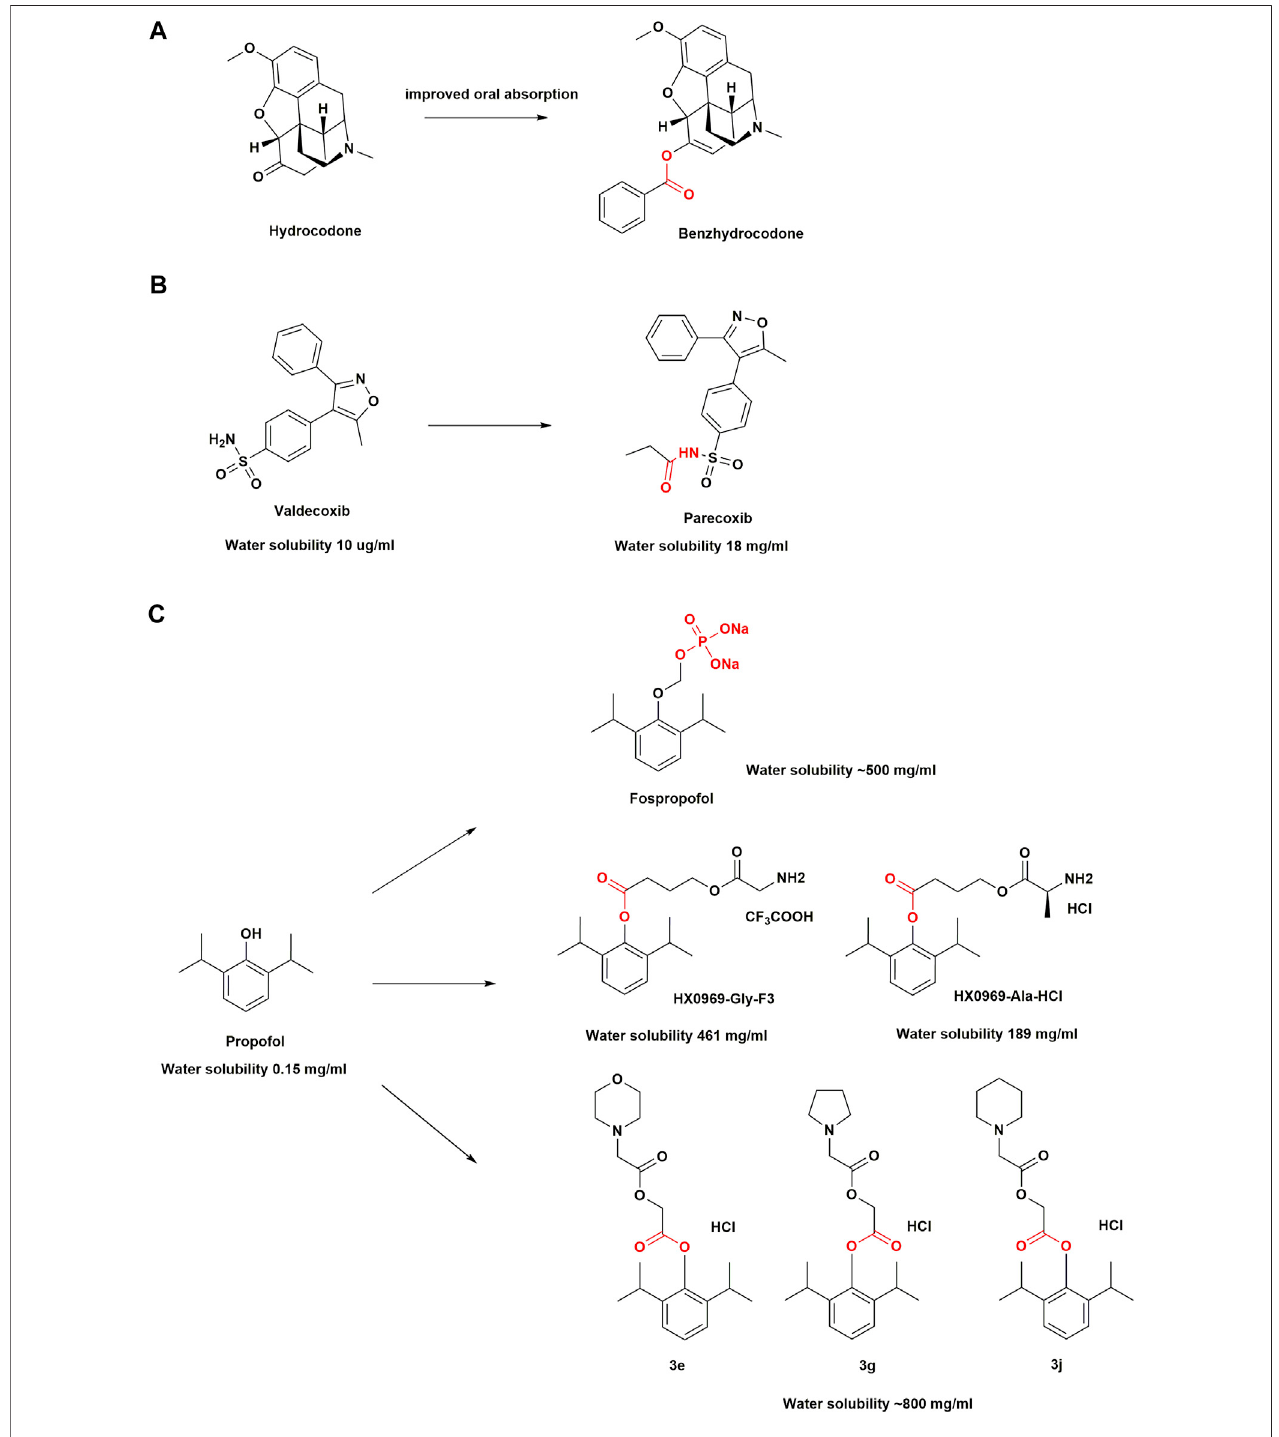
FIGURE 2 | Structural optimization in anesthetic drugs with prodrug design. (A) Hydrocodone and its ester prodrug; (B) Valdecoxib and its amide prodrug; (C) Propofol prodrugs.